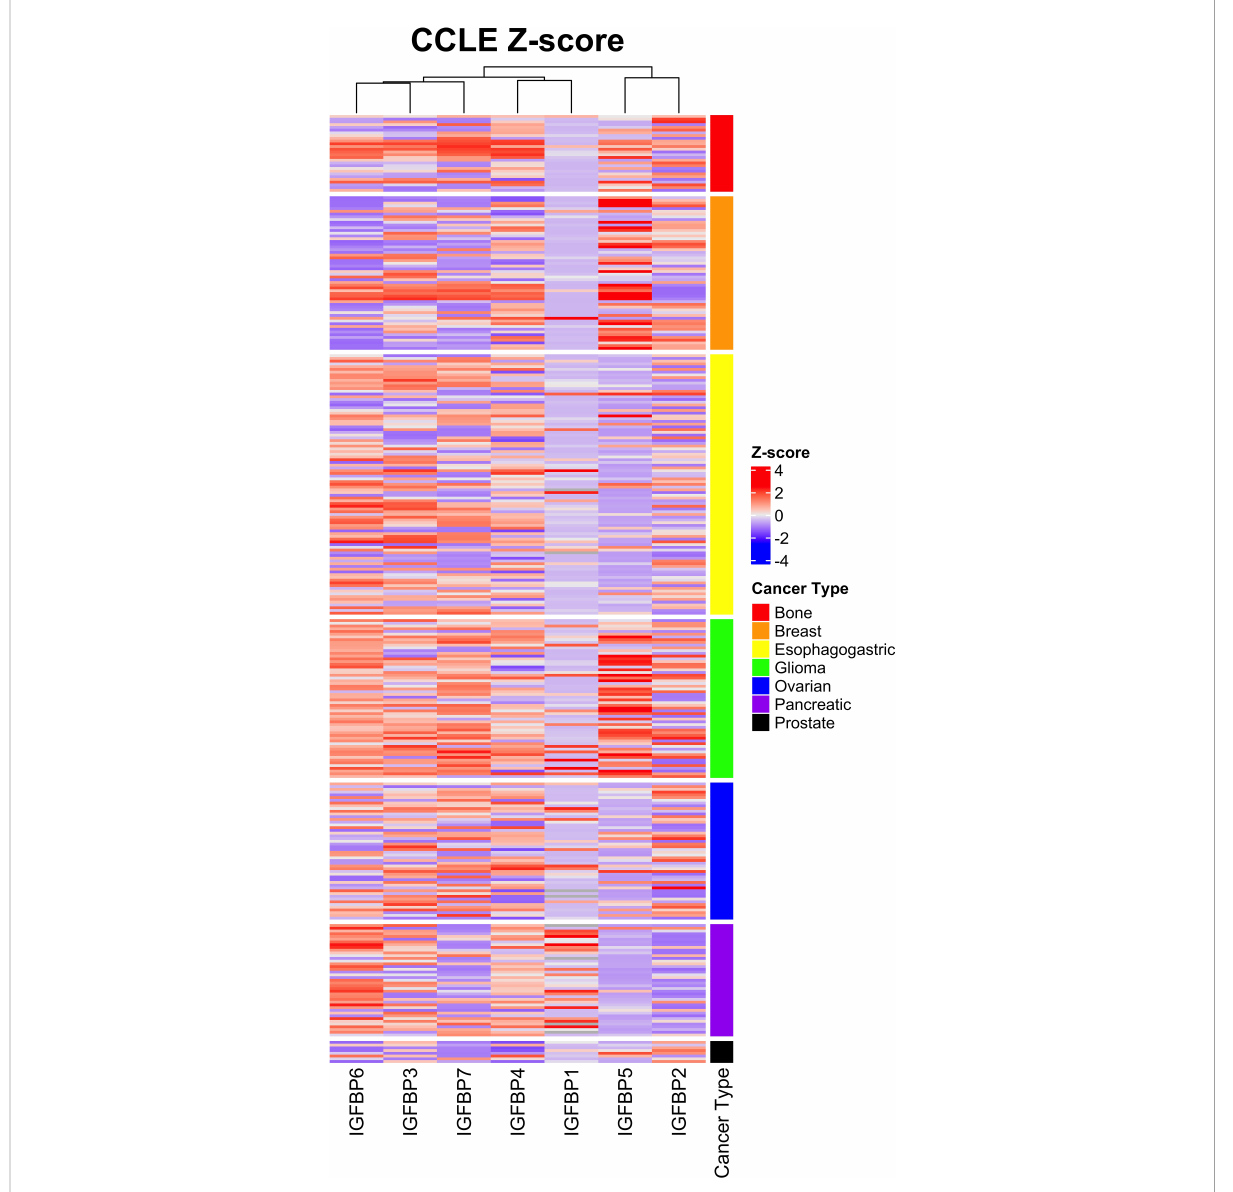
FIGURE 5 Expression of IGFBP5 in the Cancer Cell Line Encylopedia (CCLE) displayed as z-scores and clustered by cancer subtype. Normalized gene expression (mRNA expression z-scores relative to all samples, log RNA Seq RPKM) values and cancer subtype were downloaded from The Cancer Genome Atlas on cbioportal and reconstructed in excel by unique patient ID. Heatmap was generated using ComplexHeatmap in rstudio. The cancer subtype cluster are shown above with the indicated